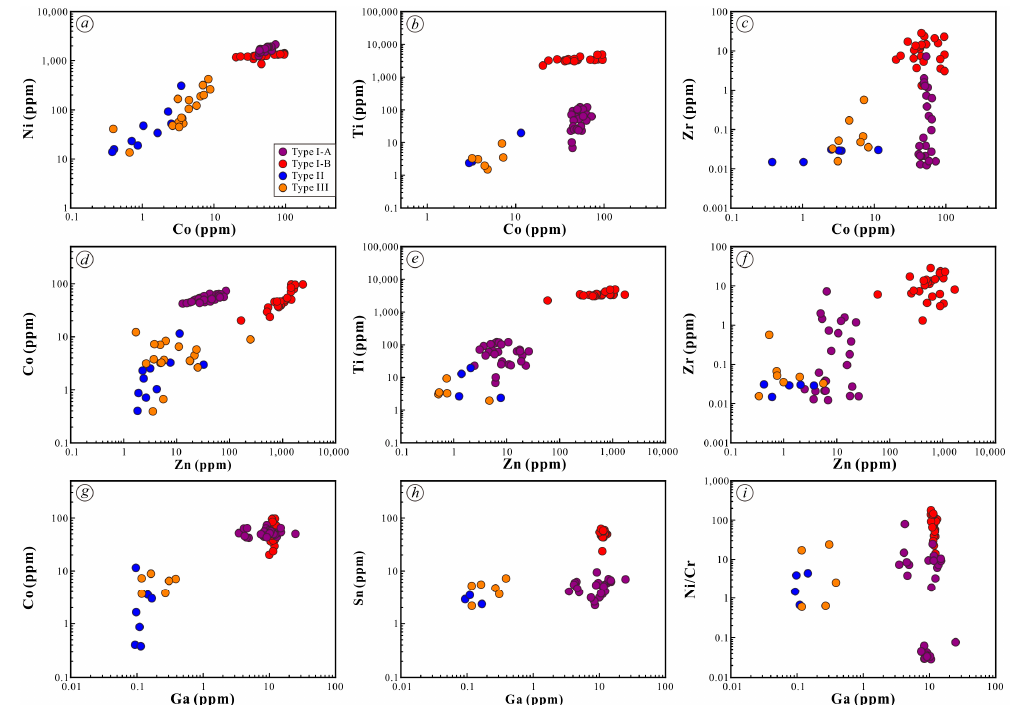
Figure 4. Binary diagrams of ( a ) Ni vs. Co, ( b ) Ti vs. Co, ( c ) Zr vs. Co, ( d ) Co vs. Zn, ( e ) Ti vs. Zn, ( f ) Zr vs. Zn, ( g ) Co vs. Ga, ( h ) Sn vs. Ga, and ( i ) Ni/Cr vs. Ga for the Jinchuan different types of magnetite in massive and disseminated sulfide ores.